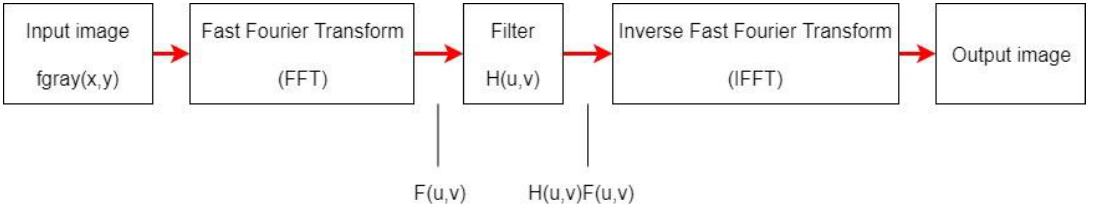
Figure 2. Flowchart of fast Fourier transform (FFT).